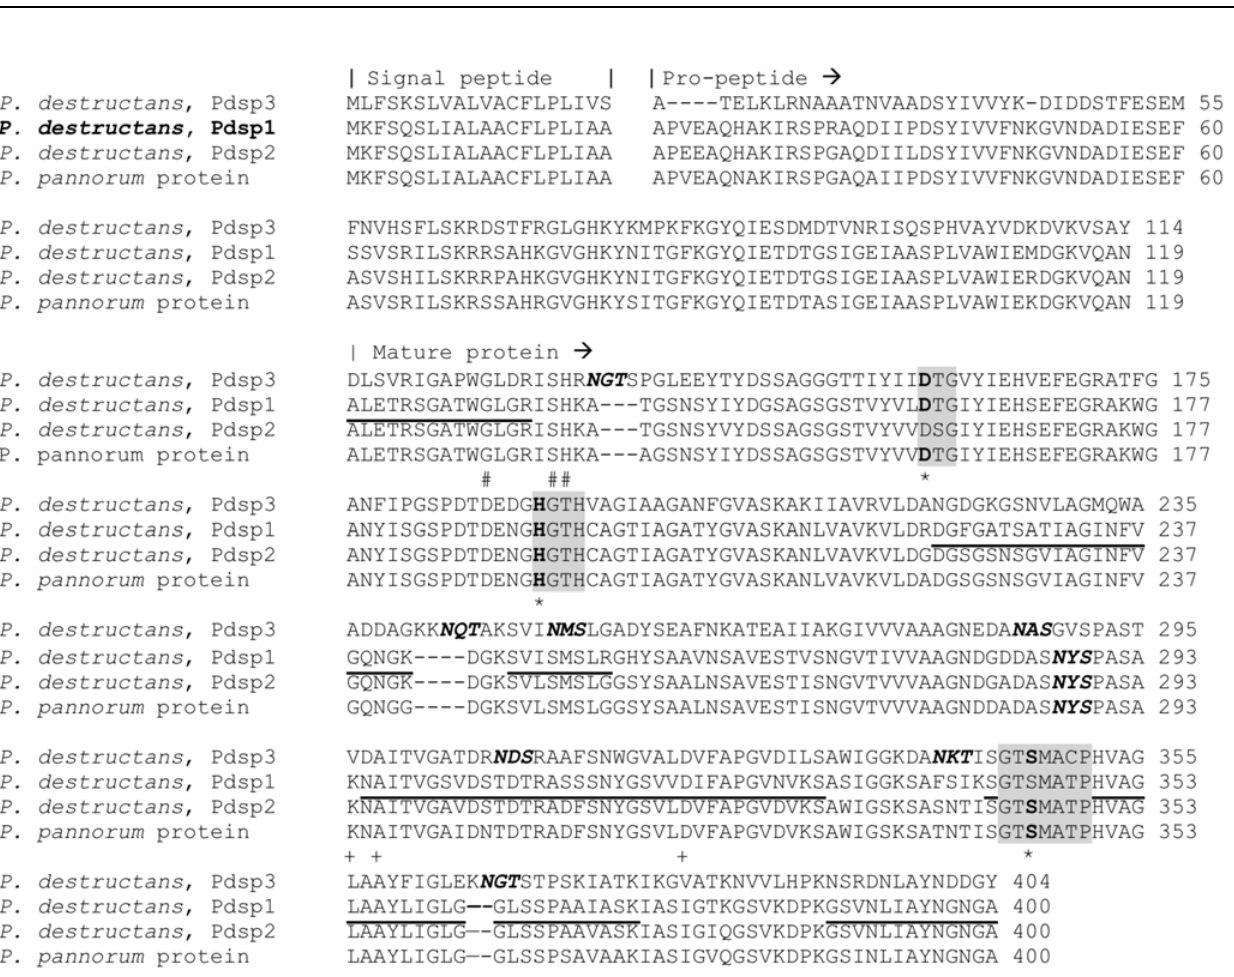
Fig 6. Sequence alignment of Pseudogymnoascus spp . Family S8 serine proteases. Sequences identified from GenBank accessions: P . destructans , PdSP3, ELR10046.1; P . destructans , PdSP1, ELR07576.1; P . destructans , PdSP2, ELR03877.1; and P . pannorum KFZ06449.1. Location of catalytic triad, D 160 , H 192 , and S 345 (indicated by * below sequence) with conserved motifs for S8A subfamily indicated in gray boxes. Residues predicted to participate in calcium-binding are also indicated below sequences for sites C1 (+) and C2 (#). Amino acids sequences determined experimentally from PdSP1 are underlined. N -glycosylation sequons (N-X-S/T) are indicated in bold italics. Alignment prepared with ClustalW